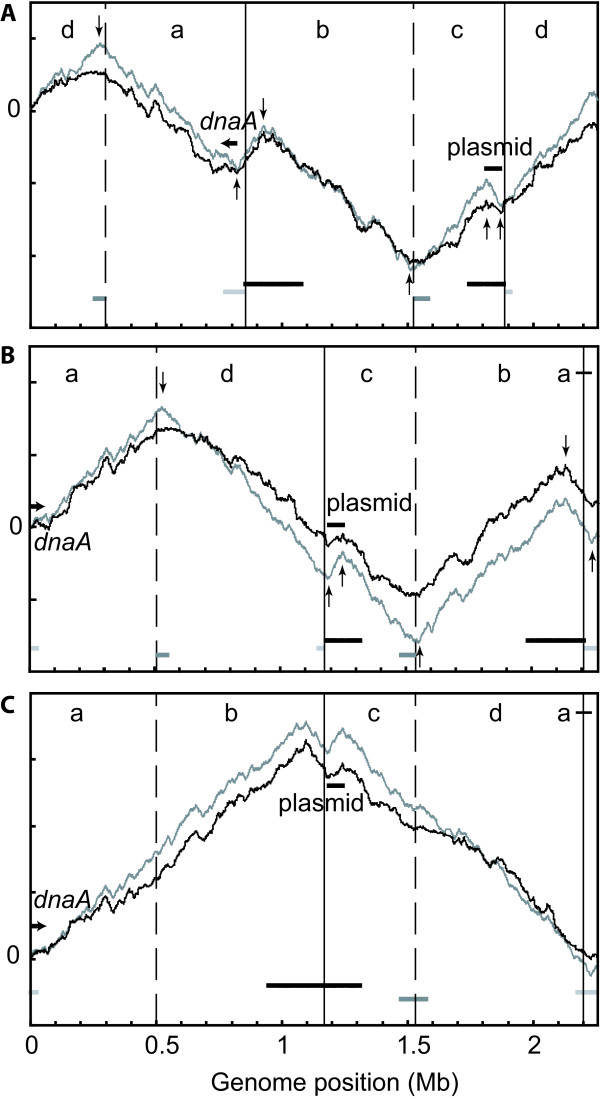
Genometric analyses of the two chromosomal configurations of B. longum NCC2705. Cumulative GC- and ORF orientation skew analyses of chromosomal configurations I (A, B) and II (C) of B. longum NCC2705. Configuration I [GenBank:NC_004307.1] is plotted without modification with respect to the version available on databases (Watson strand), (A) as well as the Crick strand of same sequence starting with the gene dnaA (B). Cumulative GC skew of the first codon position (black curve) and cumulative ORF orientation skew (grey curve) are plotted as a function of their position on the genome. Distance between two graduation marks represents an excess of 104 Gs over Cs in the first codon position cumulative GC skew and of 2·103 nucleotides in the ORF orientation skew. Thin arrows indicate relevant changes of the slope sign. The thick arrow corresponds to the position and the orientation of dnaA. The location of the integrated plasmid described in [4] is indicated. Vertical lines specify the position of copies of ISBlo2 (dashed line) and ISBlo5 (full line) insertion sequences. Segments delimited by these insertion sequences are designated a, b, c and d. Horizontal lines below the curves are the hits of scaffolds 1 (black), 8 (light grey) and 9 (dark grey) of B. longum DJO10A when BLASTed against the B. longum NCC2705 genome in configurations I (A, B) or II (C).